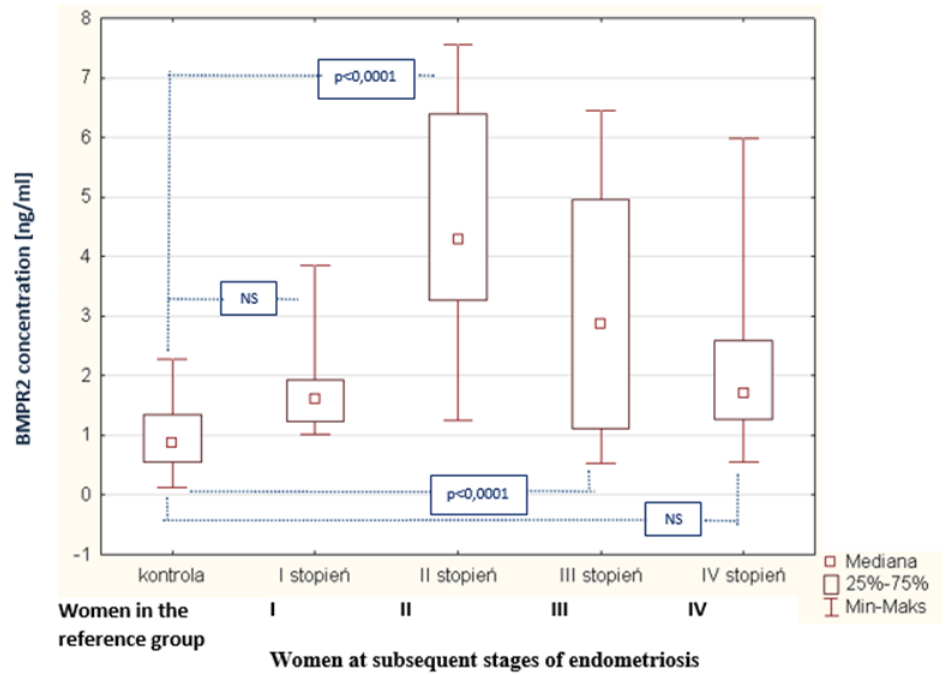
Figure 8. BMPR2 concentration in the peritoneal fluid of women at subsequent stages of endometriosis and women in the reference group.